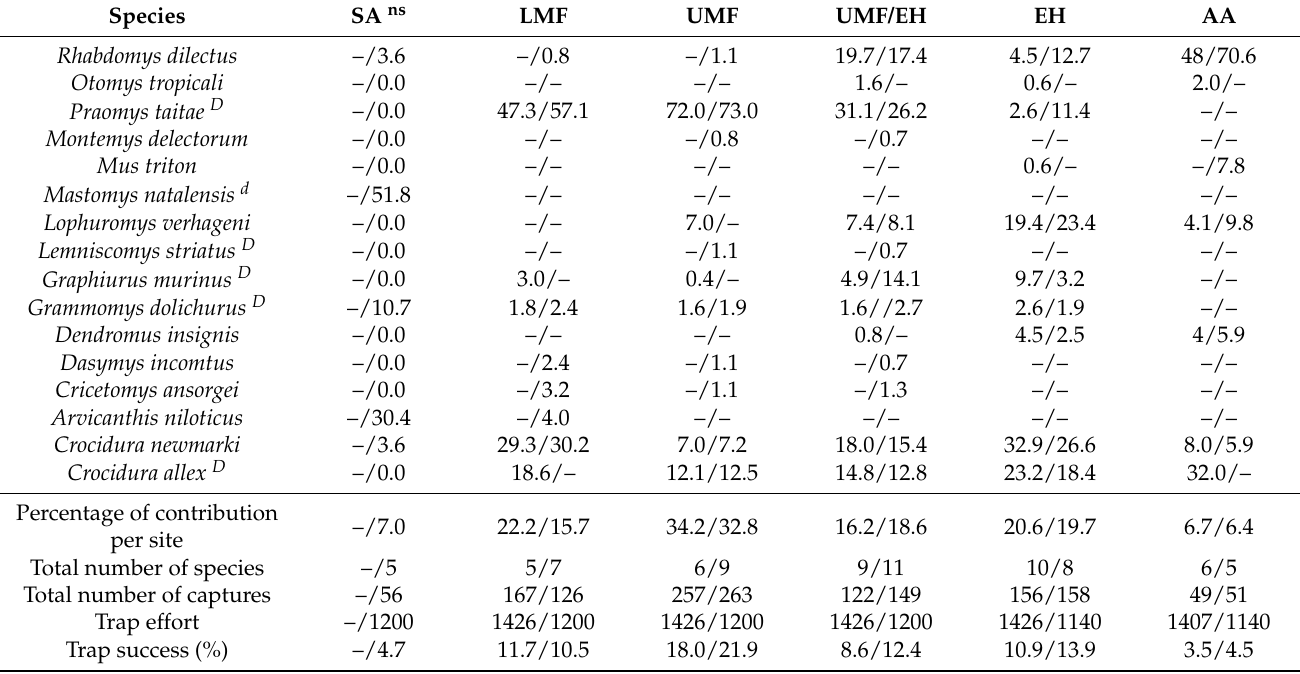
Table 4. Occurrence data in terms of percentage of relative abundance for each species, by elevation zone, in 2009 (numerator) and 2021 (denominator) on Mount